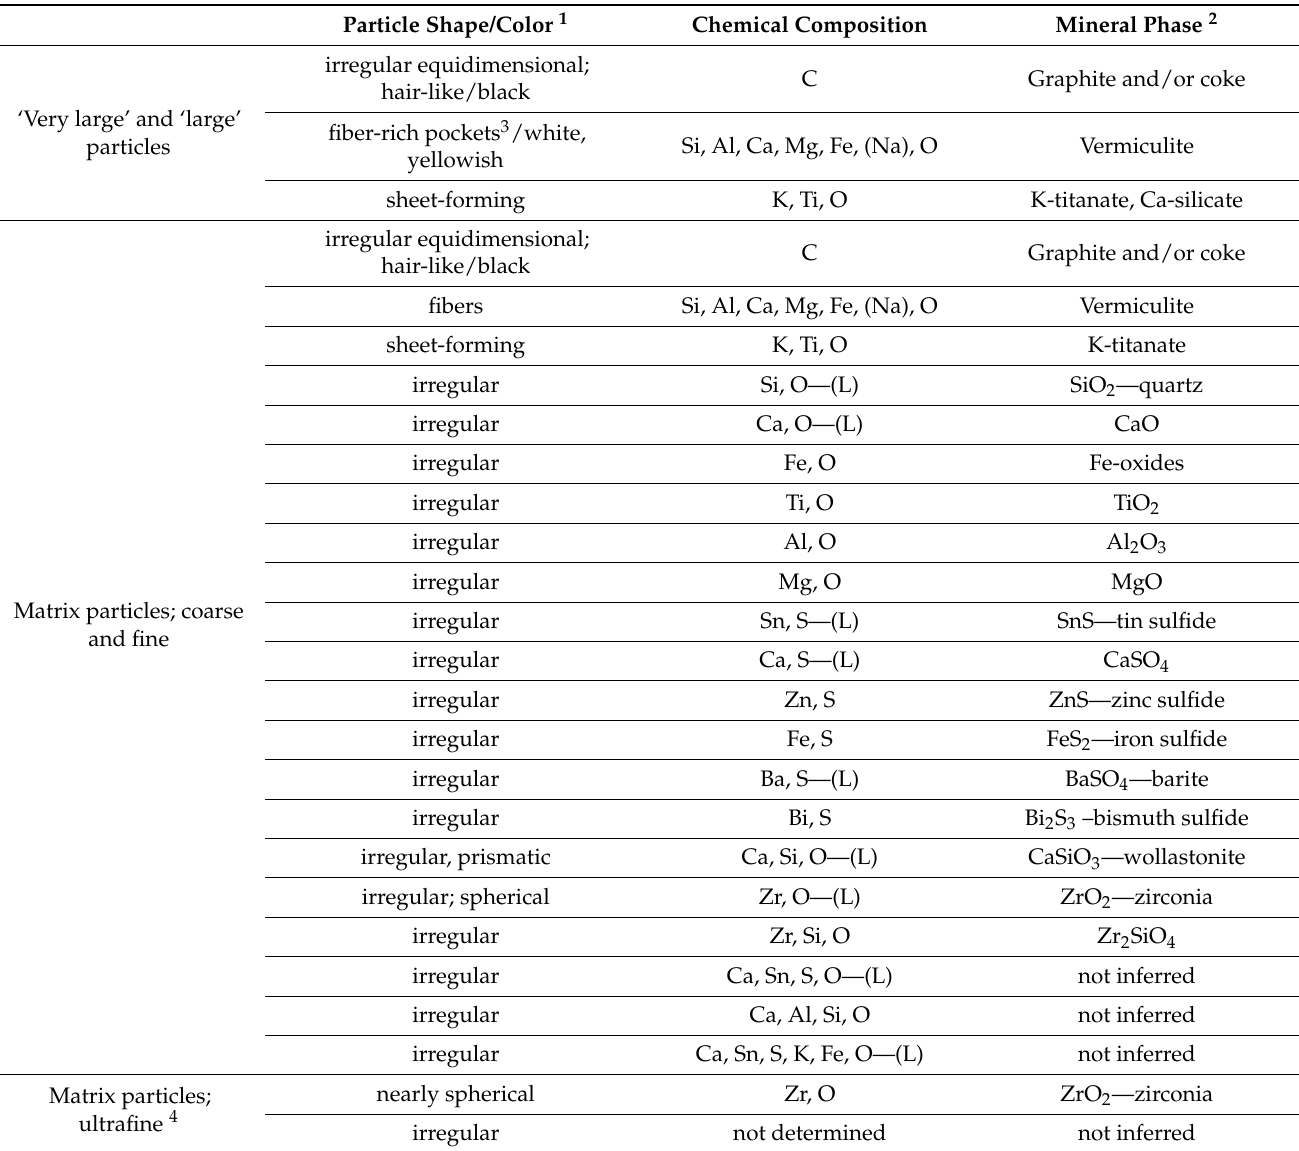
Table 1. Particle types in the new brake pad: morphology, qualitative chemical composition and corresponding (presumed) mineral